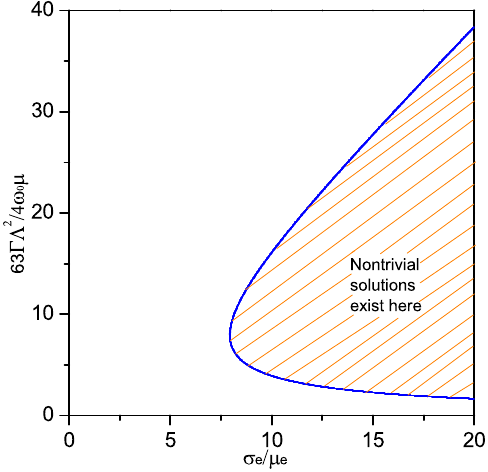
Figure 8. Regions where the subharmonic response exists.